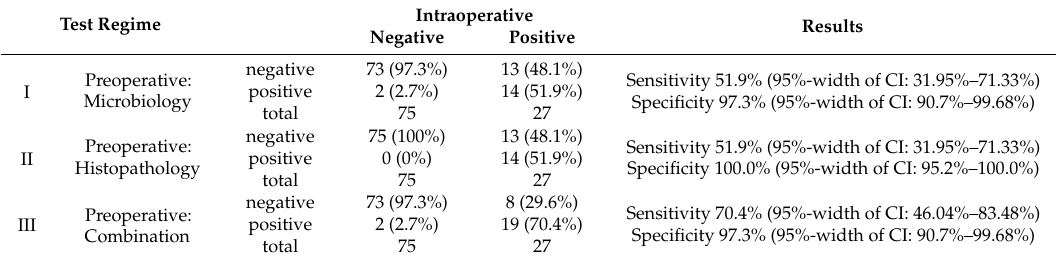
Table 2. Test Regime for Arthrocentesis Compared to Intraoperative